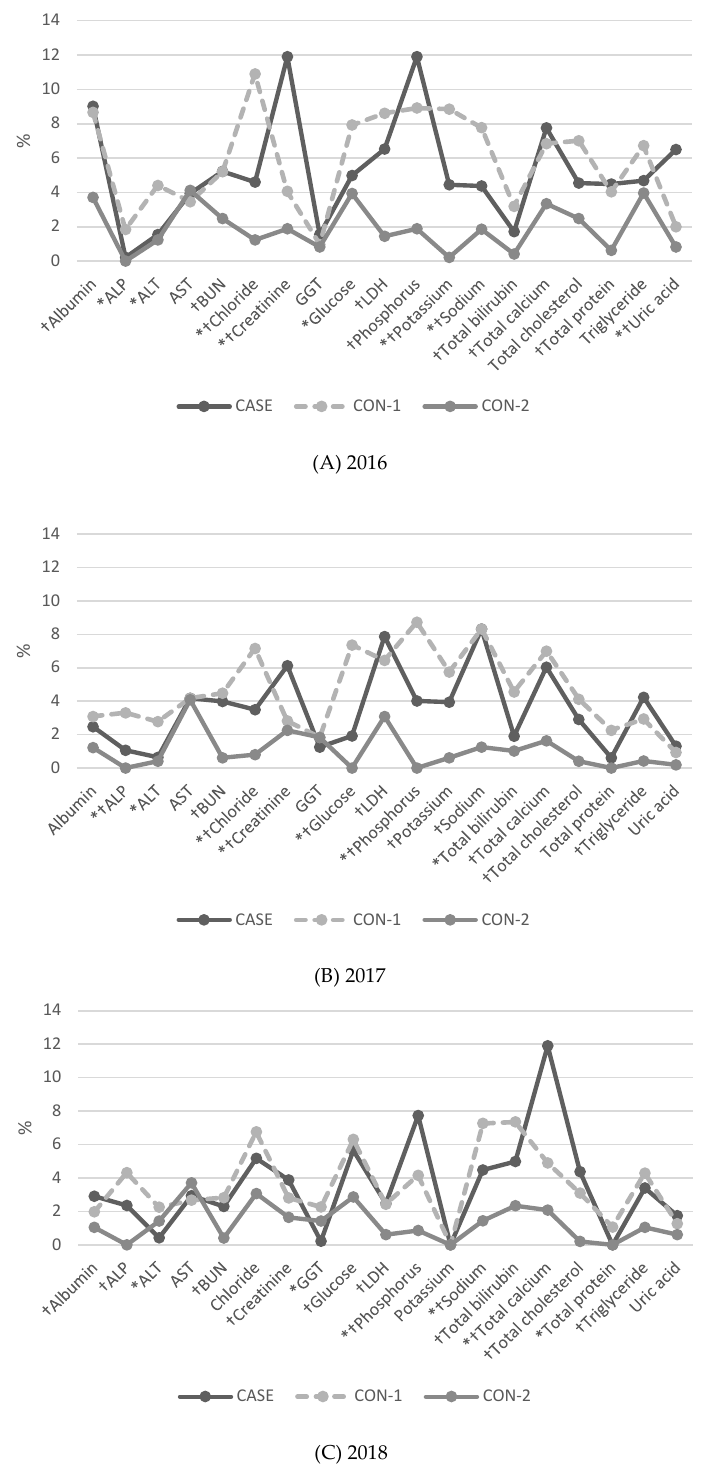
Figure 1. The proportion (%) of general chemistry results of more than 2 standard deviation indexes (SDIs) of Korean Association of External Quality Assessment Service (KEQAS) external quality assessment (EQA) over three years: ( A ) 2016, ( B ) 2017, ( C ) 2018. Abbreviation: CON-1, control 1; CON-2, control 2. * p value by chi-square test was lower than 0.05 between CASE and CON-1. † p value by chi-square test was lower than 0.05 between CASE and CON-2. ALP: alkaline phosphatase, ALT: alanine aminotransferase; AST: aspartate transaminase; BUN: blood urea nitrogen; GGT: γ-glutamyl transferase; LDH: lactate